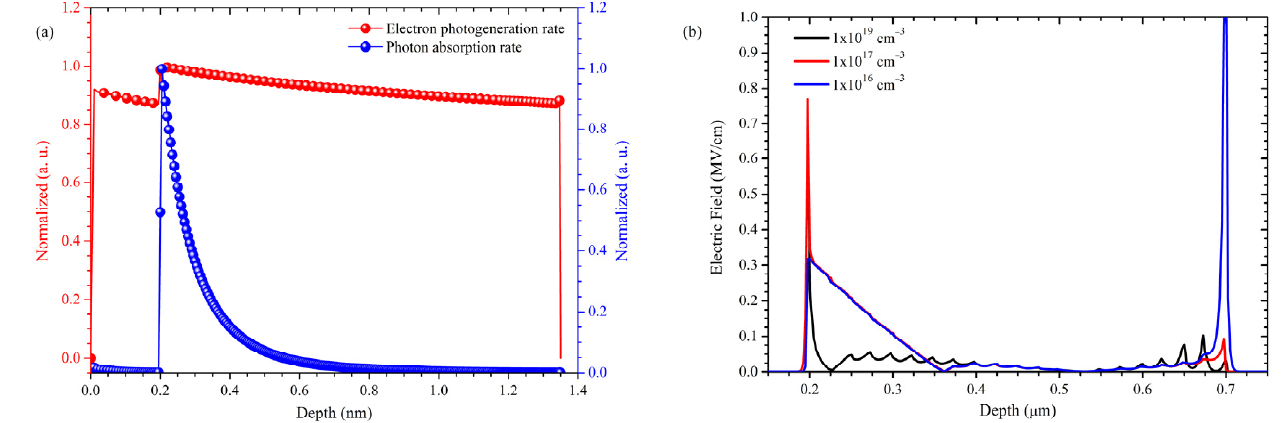
Figure 6. ( a ) Photon absorption in the structure and ( b ) influence of electron concentration in the absorber layer on the electric field.